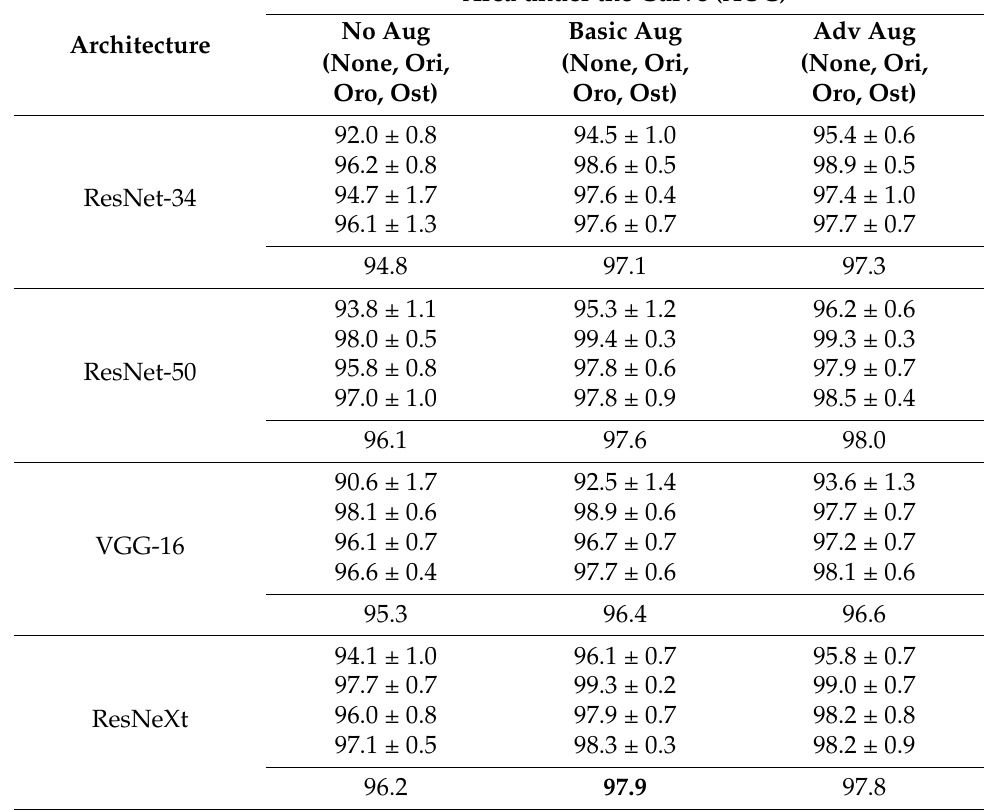
Area under the Curve